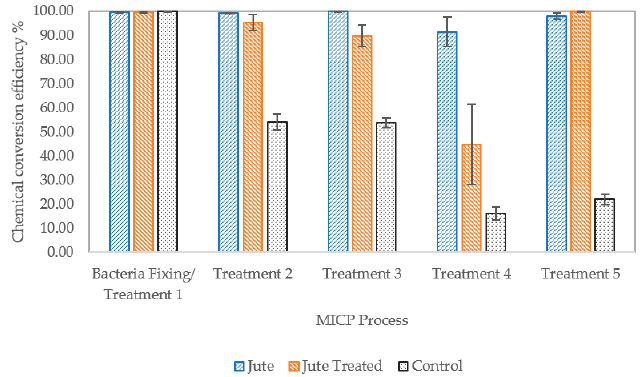
Figure 9. Chemical conversion efficiency, with error bars showing standard deviation of triplicates.